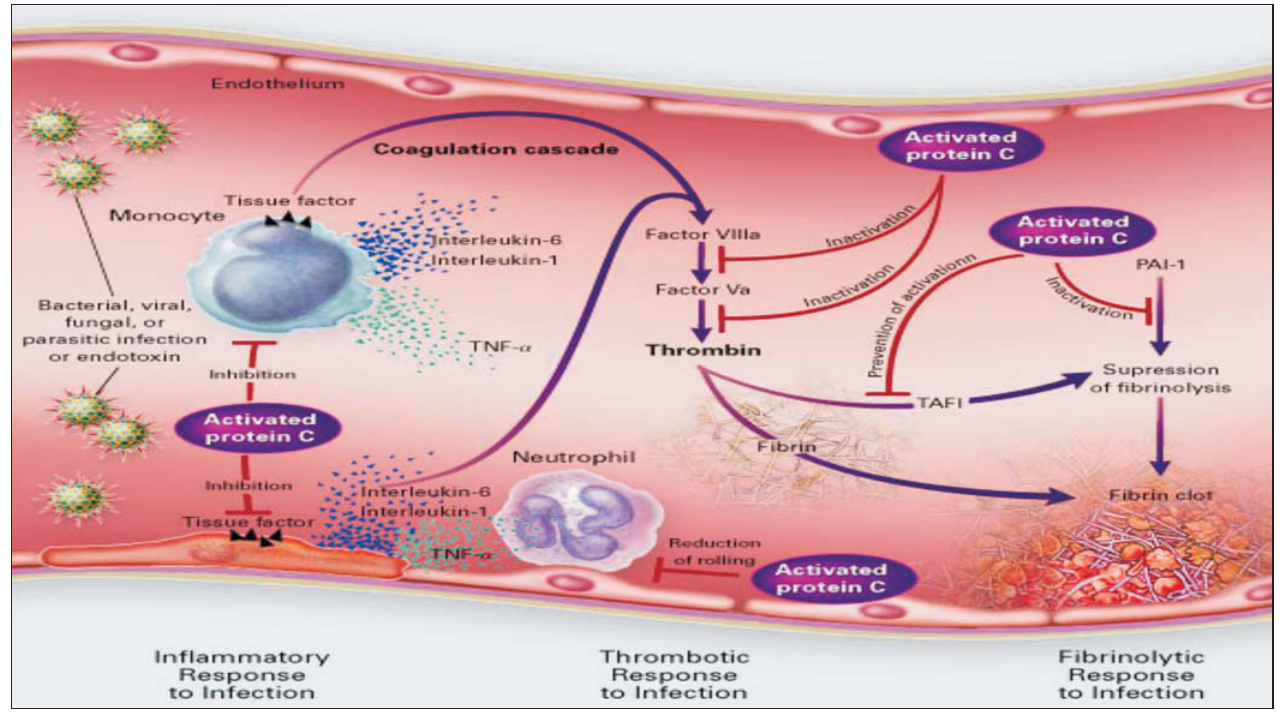
Figure 1) The role of inflammation, fibrinolysis and coagulation in infection. The inflammatory and procoagulant host responses to infection are intri- cately linked. Infectious agents and inflammatory cytokines such as tumour necrosis factor-alpha (TNF- α ) and interleukin-1 activate coagulation by stimulating the release of tissue factor from monocytes and the endothelium. The presentation of tissue factor leads to the formation of thrombin and a fibrin clot. Inflammatory cytokines and thrombin can both impair the endogenous fibrinolytic potential by stimulating the release of plasminogen-acti- vator inhibitor 1 (PAI-1) from platelets and the endothelium. PAI-1 is a potent inhibitor of tissue plasminogen activator, the endogenous pathway for lysing a fibrin clot. In addition, the procoagulant thrombin is capable of stimulating multiple inflammatory pathways and further suppressing the endoge- nous fibrinolytic system by activating thrombin-activatable fibrinolysis inhibitor (TAFI). The conversion of protein C, by thrombin bound to throm- bomodulin, to the serine protease activated protein C is impaired by the inflammatory response. Endothelial injury results in decreased thrombomodulin levels. The end result of the host response to infection may be the development of diffuse endovascular injury, microvascular thrombosis, organ ischemia, multiorgan dysfunction and death. Activated protein C can intervene at multiple points during the systemic response to infection. It exerts an antithrombotic effect by inactivating factors Va and VIIIa, limiting the generation of thrombin. As a result of decreased thrombin levels, the inflam- matory, procoagulant and antifibrinolytic response induced by thrombin is reduced. In vitro data indicate that activated protein C exerts an anti-inflam- matory effect by inhibiting the production of inflammatory cytokines (TNF- α , interleukin-1 and interleukin-6) by monocytes and limiting the rolling of monocytes and neutrophils on injured endothelium by binding selectins. Activated protein C indirectly increases the fibrinolytic response by inhibit- ing PAI-1. Reproduced with permission from reference